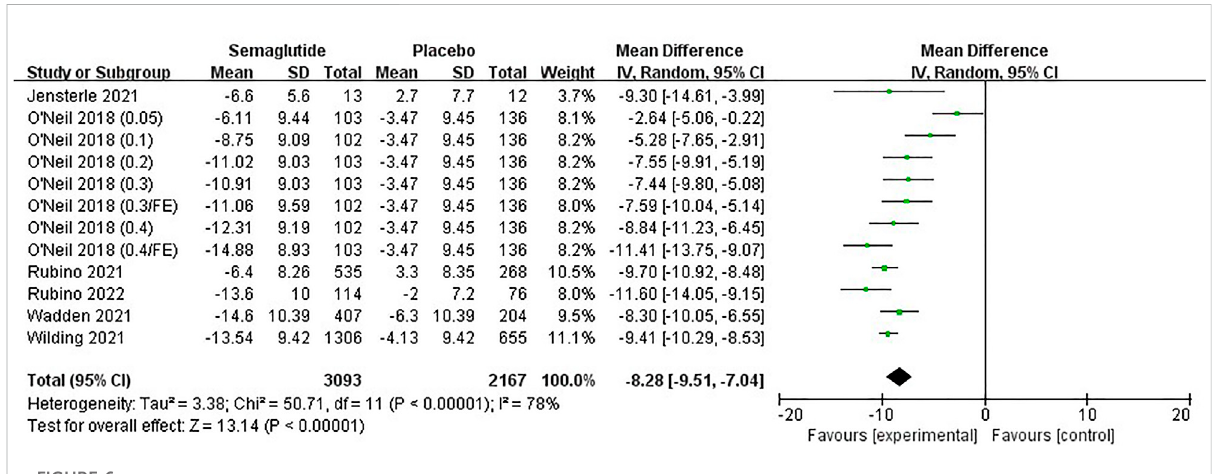
FIGURE 6 Meta-analysis results of WC change (cm) in included trials.